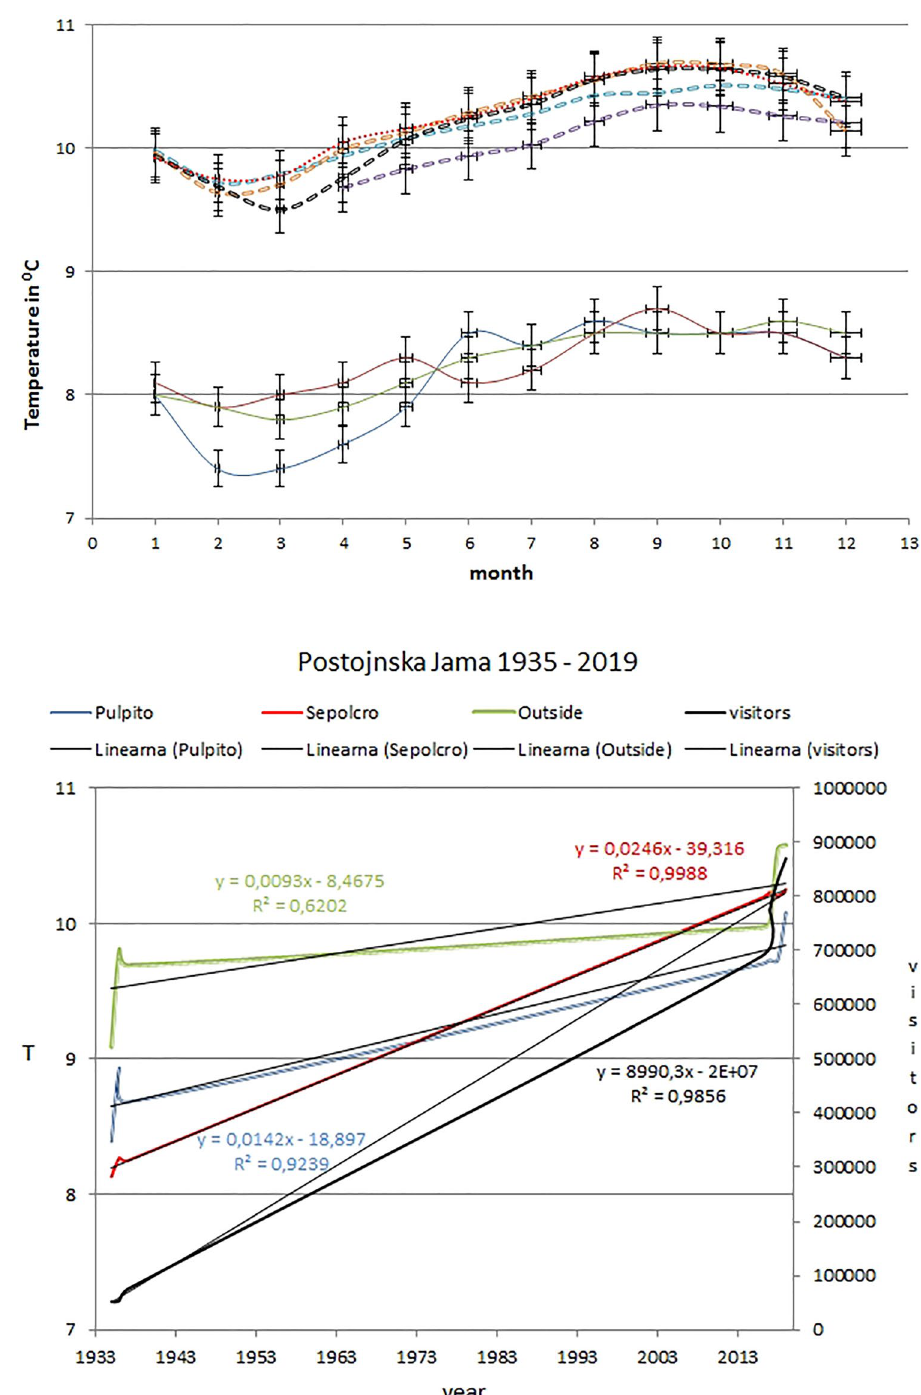
Fig. 3 Comparison of mean monthly historical [12] and current air temperatures (in °C) at the Sepolcro monitoring site